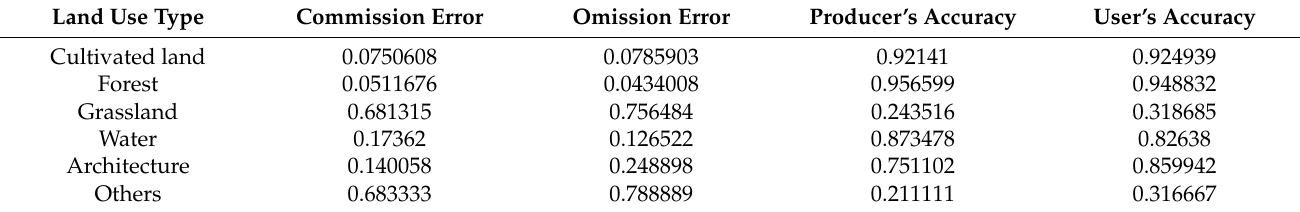
Table 3. Validation results of random